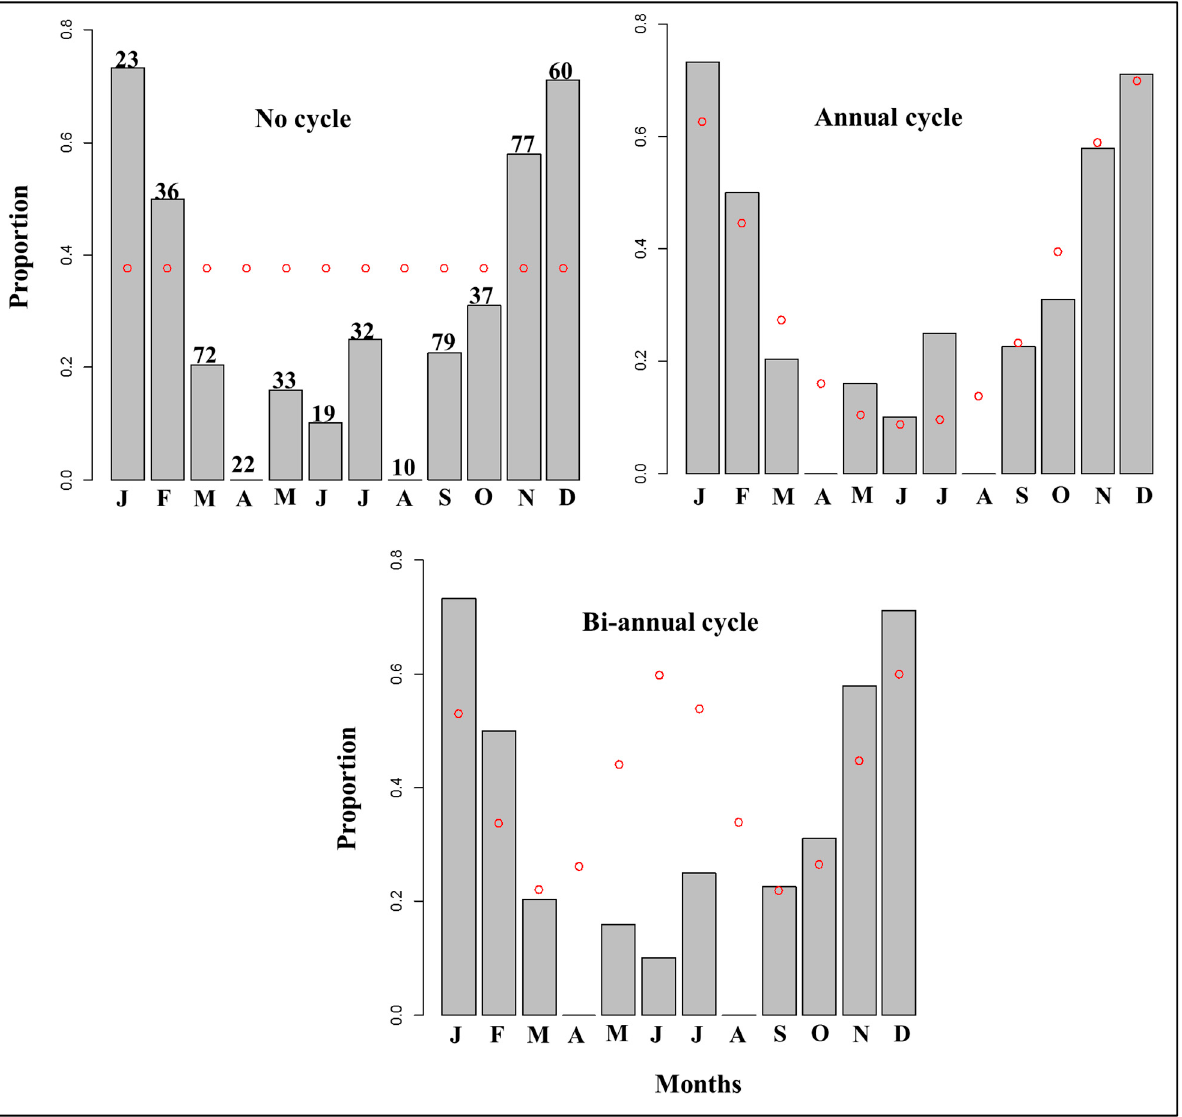
Figure 5. The proportion of asteriscus otoliths with a translucent growth zone on the edge for Labeobarbus platydorsus based on samples collected between May 2016 and April 2017 in Lake Tana, Ethiopia [140]. The bar graph denotes the proportion of the translucent growth zone and the open dot line represents the predicted model results. The numbers above the bars in the no cycle model are total sample size and the same sample size is used for the other models. The annual cycle mode best fit the data.